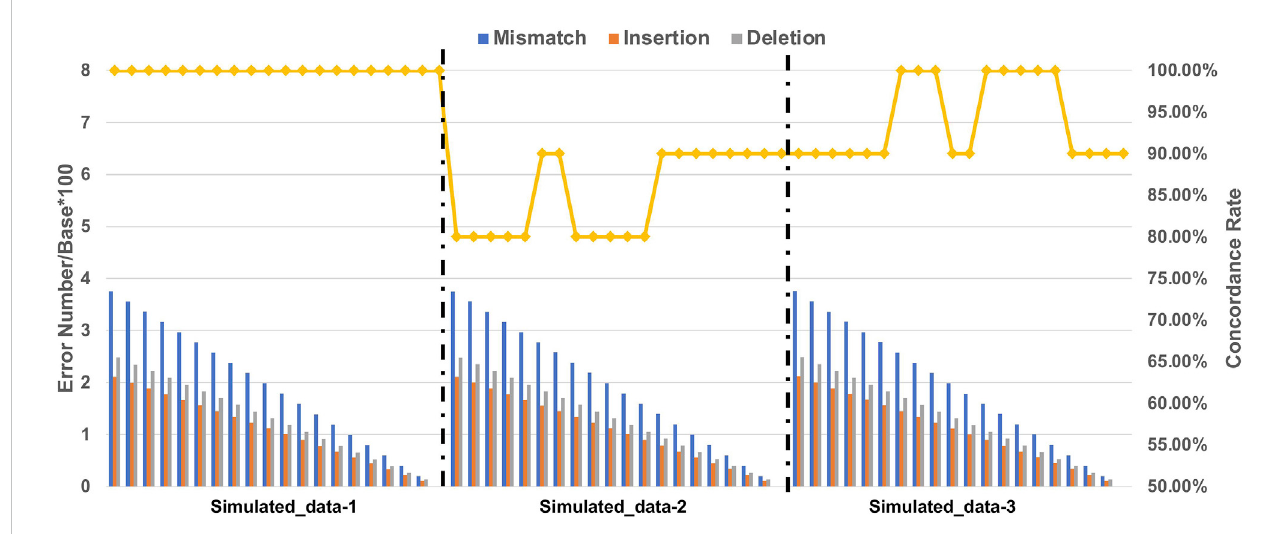
FIGURE 3 Number of errors and concordance rate of STR typing with simulated datasets. The histograms represent the number of each error type (error number/ base*100), and the rhombus symbols connected by a solid line represent the concordance rate with the expected